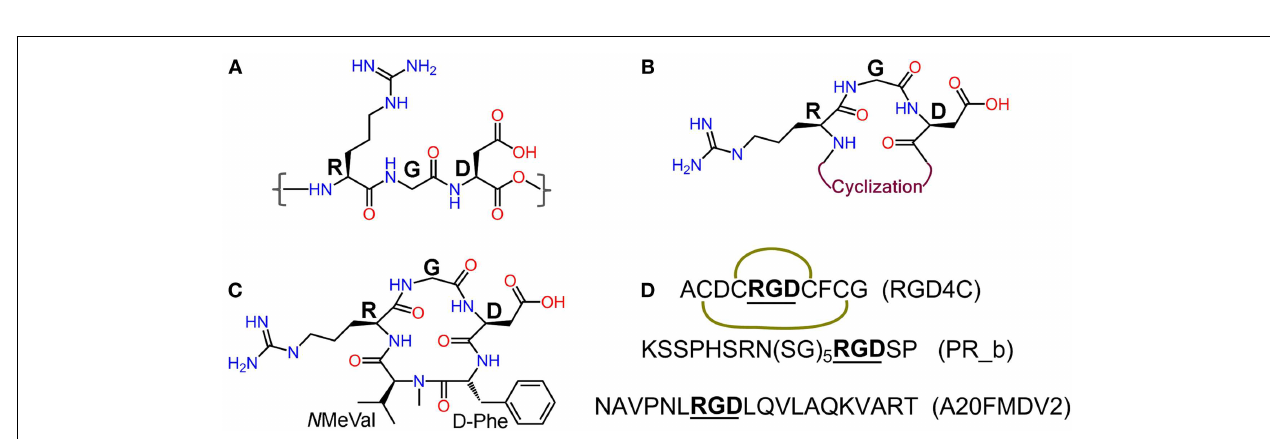
FIGURE 1 | Schematic representation of the principle of tumor targeted drug delivery for treating cancer.